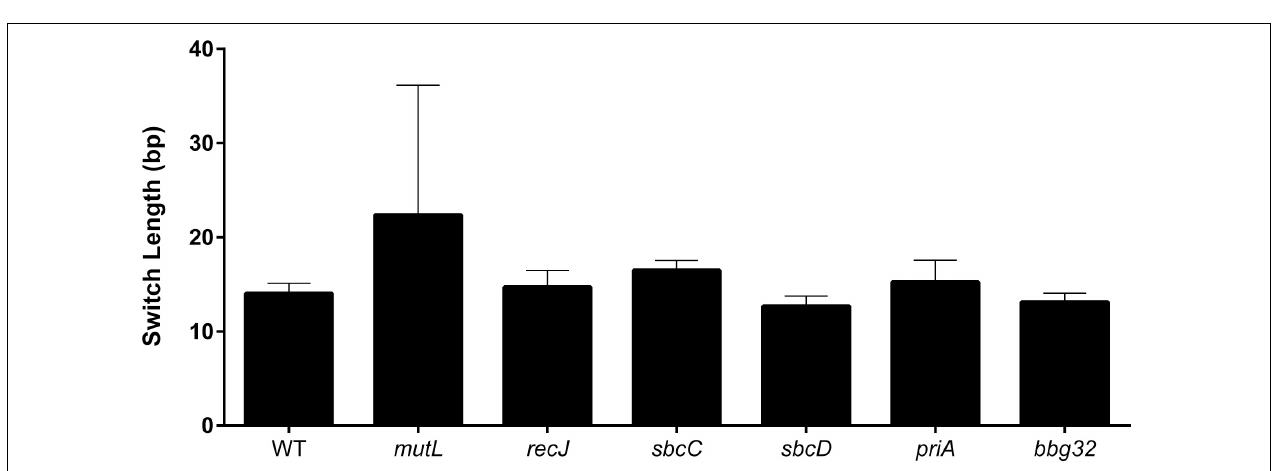
FIGURE 2 | Frequency of vlsE switching events in strains with mutant replication/recombination/repair genes. Inferred recombination are shown as a frequency per read events (gene conversion tracts per amplicon) for WT and six mutant strains of B. burgdorferi prior to (week 0) and after infection (week 5). Mean ± SEM are shown for each population of full-length vlsE amplicon sequences. The p values for each mutant versus the wild-type strain at 5 weeks is shown at the top of the graph. The p value for comparison of mutL at 0 and 5 weeks is shown above the mutL bars. The p values were determined using Dunn’s multiple comparison test.